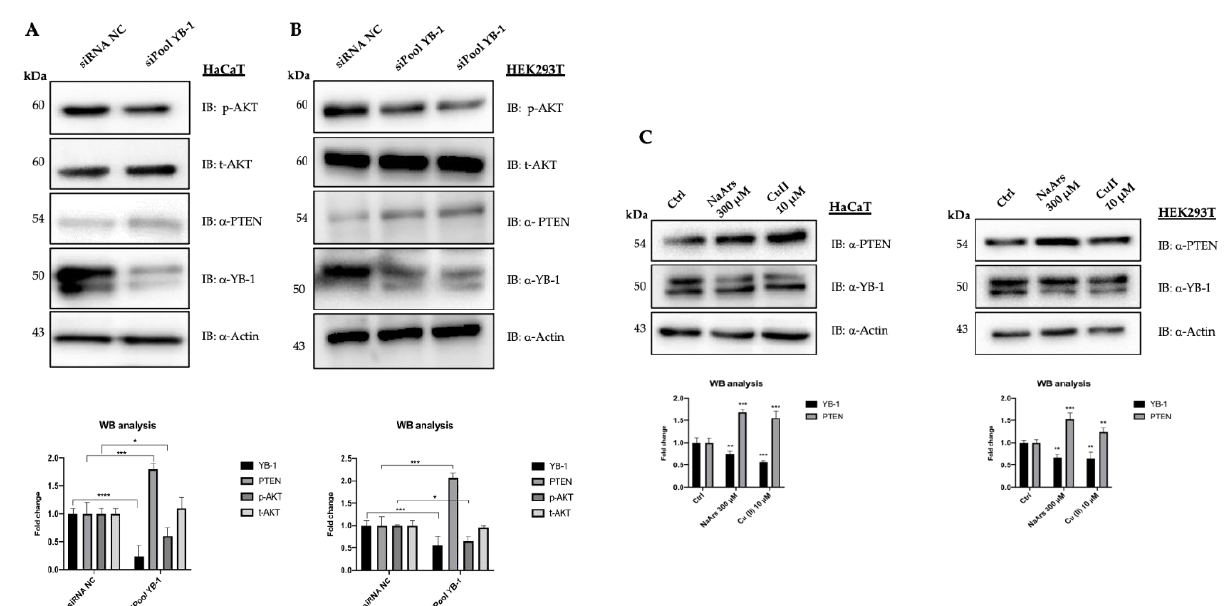
Figure 2. YB-1 controls PTEN levels in HaCaT and HEK293T cells. ( A ) HaCaT cells were transfected with 10 nM final siRNA-poolYB-1 or siRNA-Negative Control (NC). The effect on PTEN intracellular levels was evaluated 48 h post-transfection by western blot on whole protein lysates probed with anti-PTEN antibodies. Immunoblots were also probed with antibodies against YB-1, pAkt S743 , tAKT and actin as a loading control. ( B ) HEK293T cells were transfected with 10 nM final siRNA-NC or siRNA-poolYB-1 (duplicated). Whole protein lysates were collected and analysed 48 h after transfection as described in ( A ); ( C ) HaCaT and HEK293T cells were treated with NaArs and Cu (II) for 2 h to induce oxidative stress. Cell lysates were analyzed by immunoblot with antibodies against PTEN, YB1 and actin used as a loading control. For comparison, siRNA-transfected extracts were used. Statistical analyses were performed using 2-way ANOVA and Sidak’s multiple comparison or Dunnett’s multiple comparisons test. Levels of significance between points of expression are indicated (*** p < 0.001, ** p < 0.01, * p < 0.05).